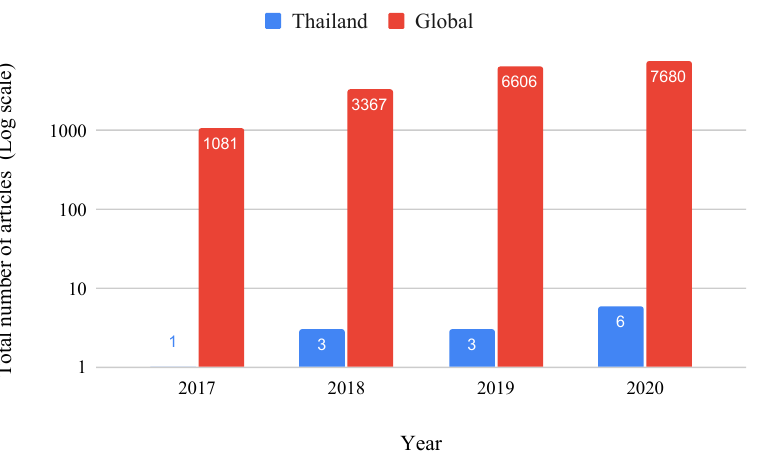
Figure 4. A comparison of the number of blockchain-based articles between Thailand and worldwide from 2017 to 2020.